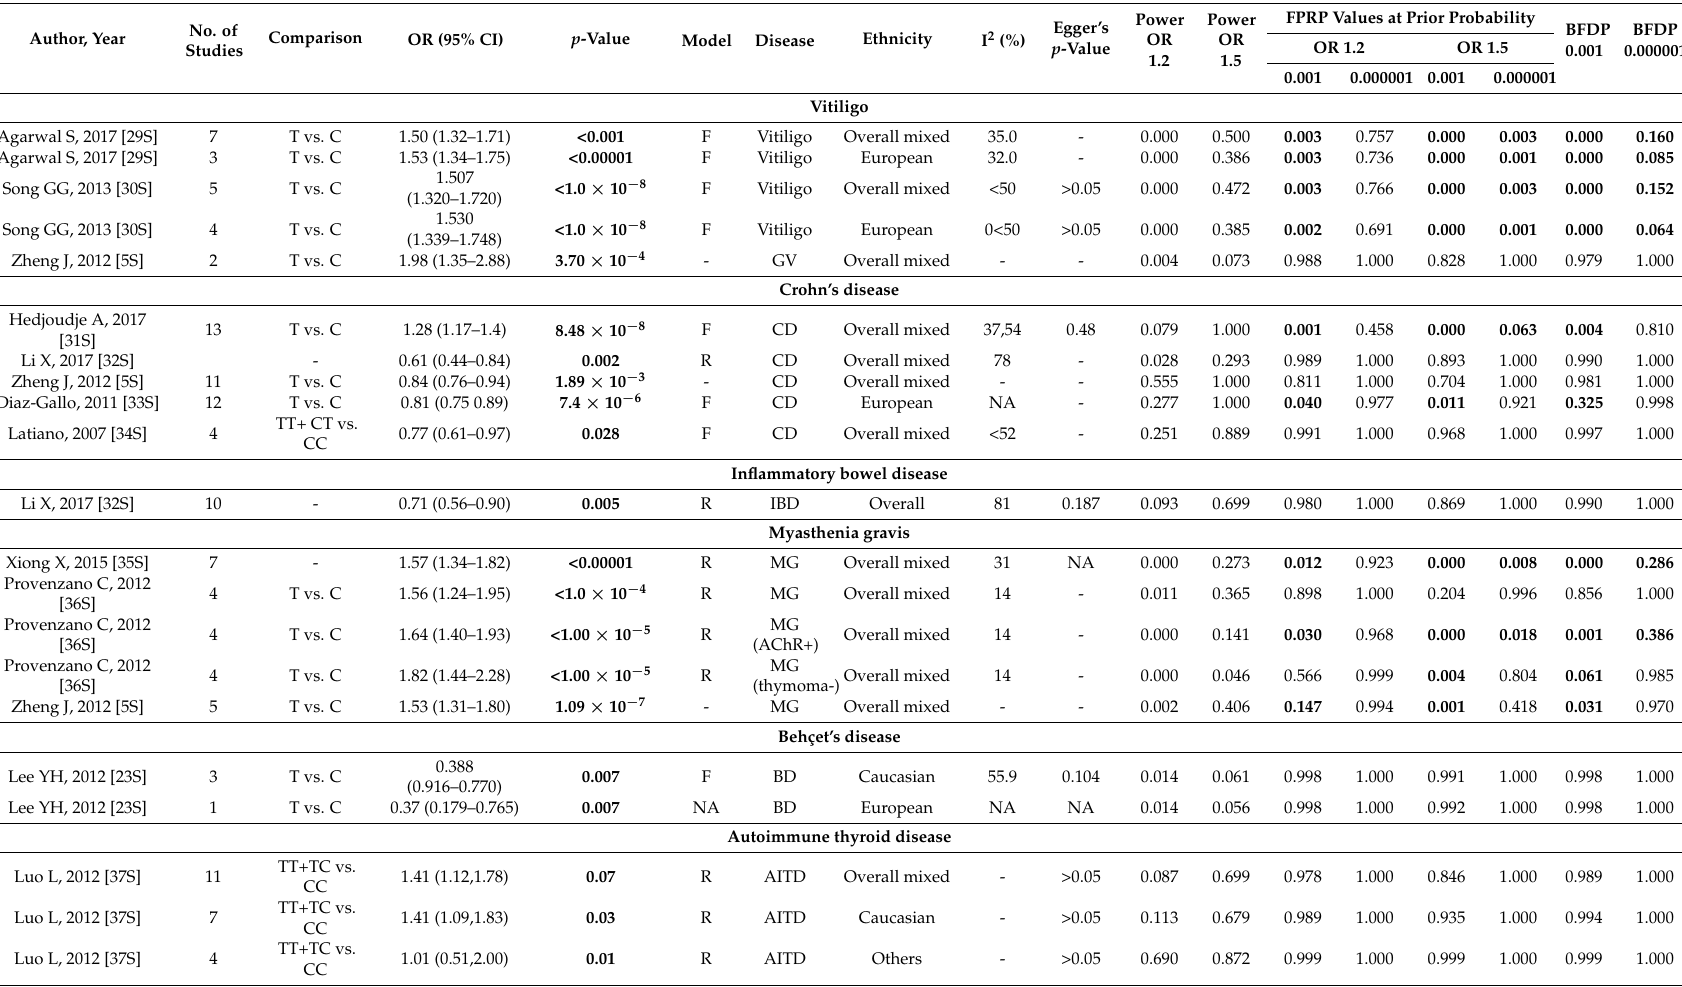
Table 6. Meta-analysis results of associations between non-rheumatic autoimmune or autoimmunity-related diseases and the PTPN22 1858 C/T polymorphism from observational